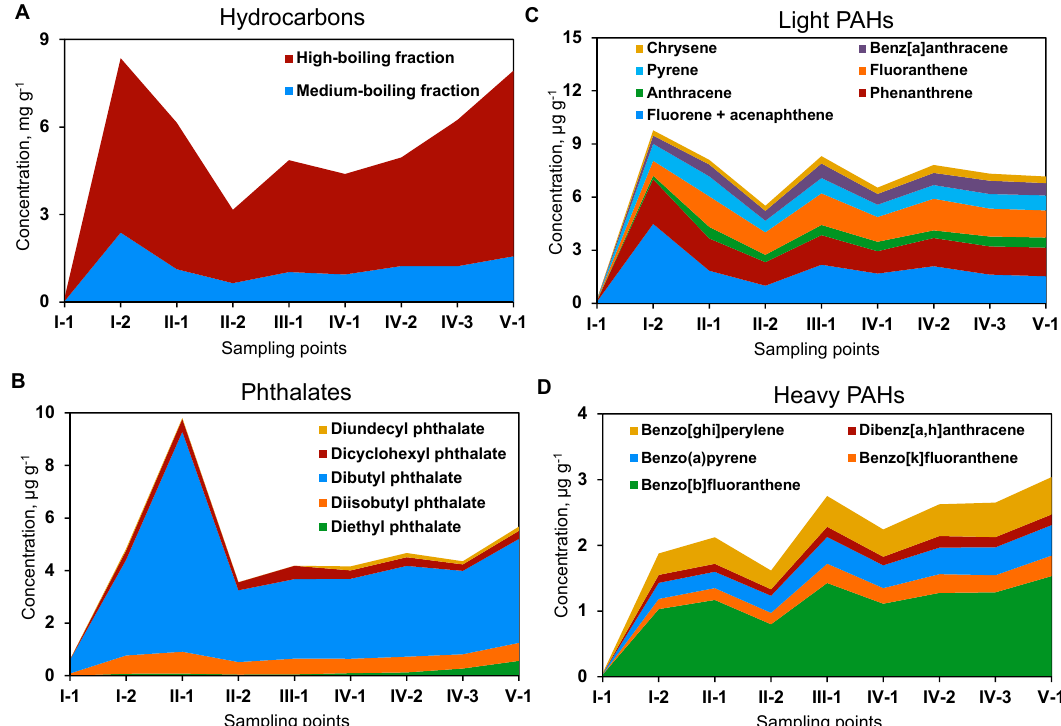
Figure 2. Chemical composition of organic pollutants in sediments of different zones of the constructed wetland. ( A ) hydrocarbons; ( B ) phthalates; ( C ) light polycyclic aromatic hydrocarbons (PAHs); ( D ) heavy PAHs.